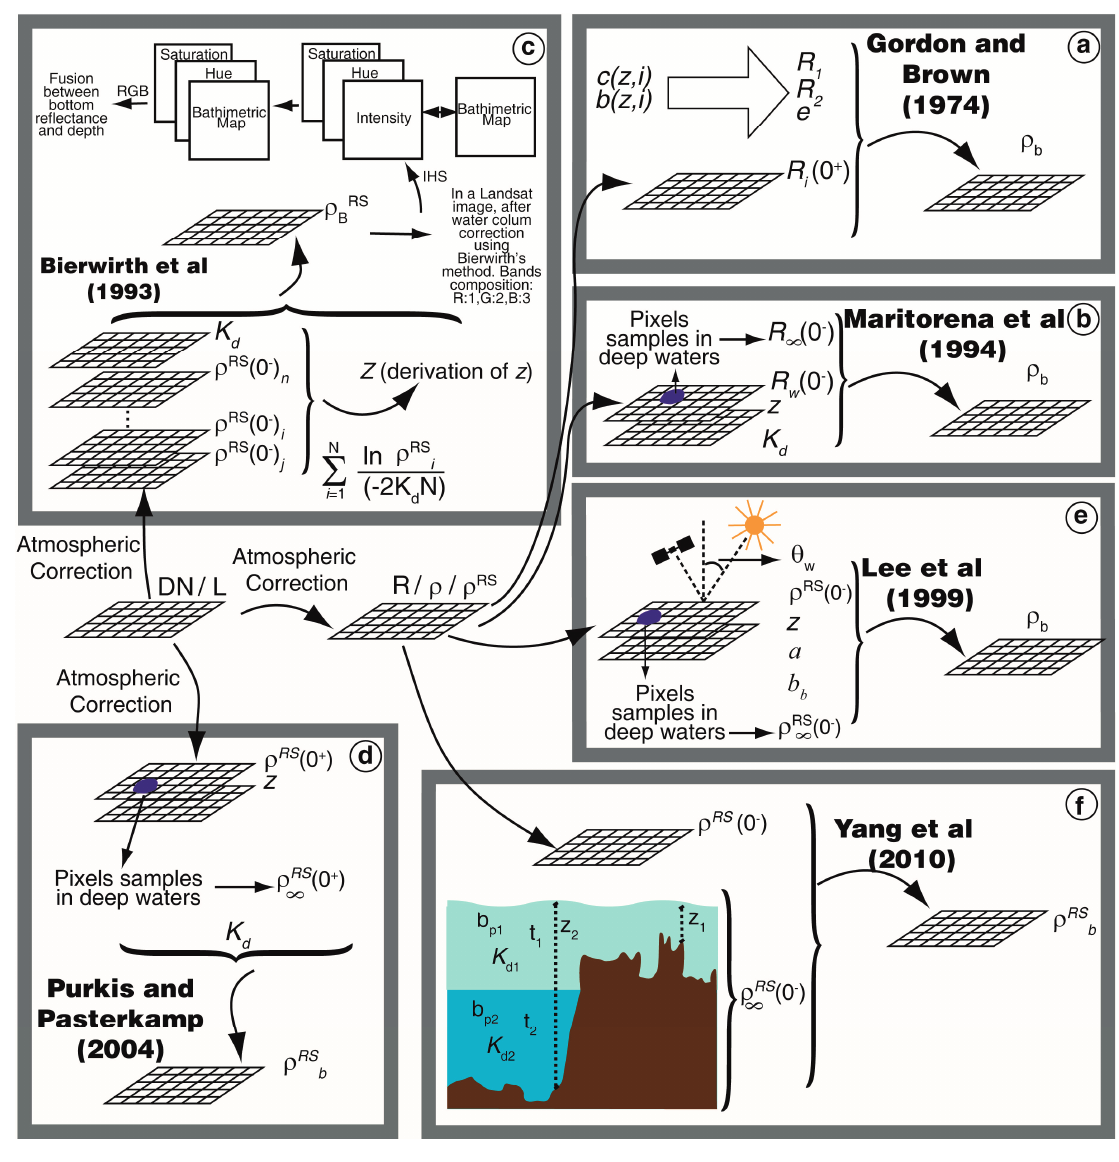
Figure 3. Starting from a remote sensing image above shallow waters, several algorithms can be applied to obtain bottom reflectance. Note that each approach uses distinct inputs. Different boxes represent different algorithms ( a ) Gordon and Brown [55]; ( b ) M94; ( c ) Bierwirth et al. [34]; ( d ) Purkis and Pasterkamp [57]; ( e ) L99; ( f ) Yang et al.